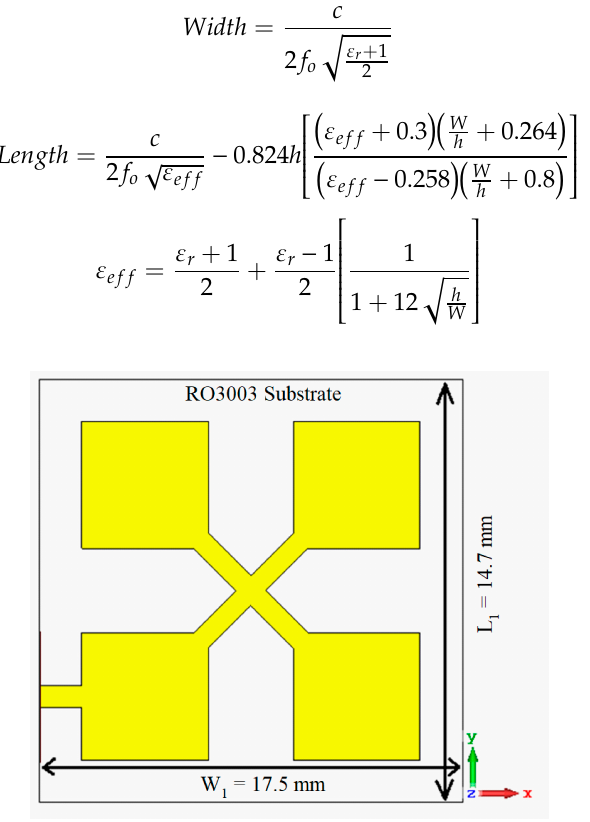
Figure 1. The proposed microstrip antenna array.